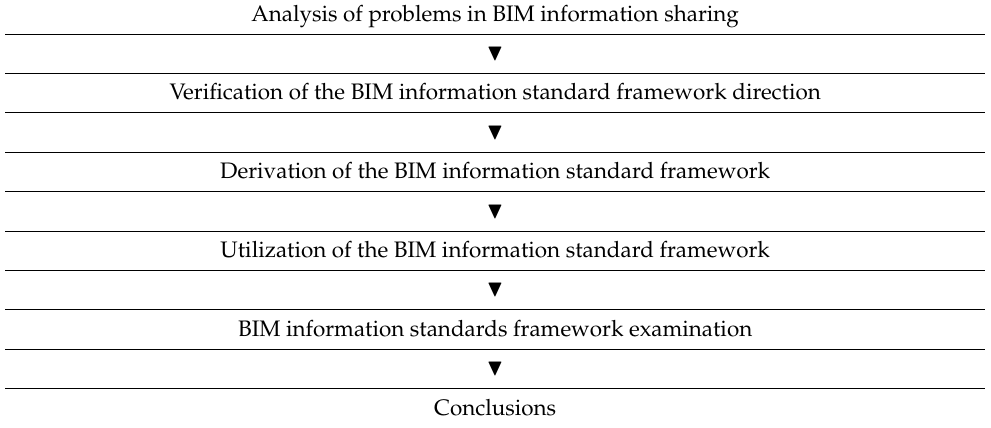
Table 1. Research method of this